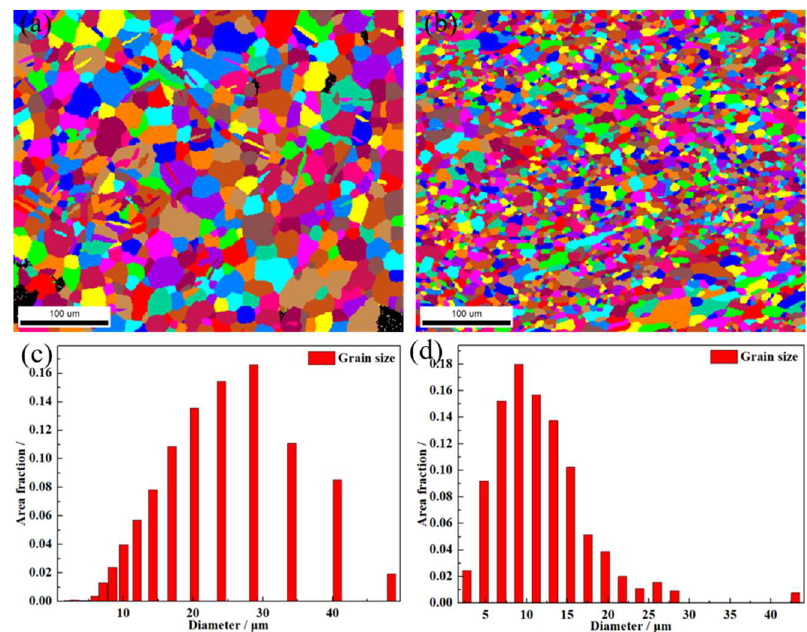
Figure 4. EBSD results of the samples with and without double-sided FSW process: ( a ) grain morphology of the BM; ( b ) grain morphology of the joint; ( c ) grain size distribution of BM; ( d ) grain size distribution of the joint.